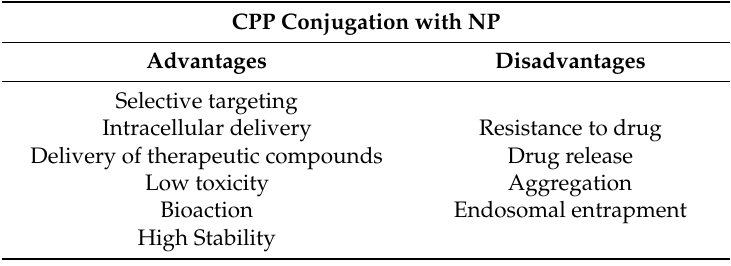
Figure 2. Schematic representation of recent CPP-based strategies. This dual conjugation of cell-penetrating peptide (CPP), nanoparticle and effector (cargo) can further potentiate the therapeutic effectiveness and enhance stability. Table 2. Advantages and disadvantages of CPP conjugation with NP.